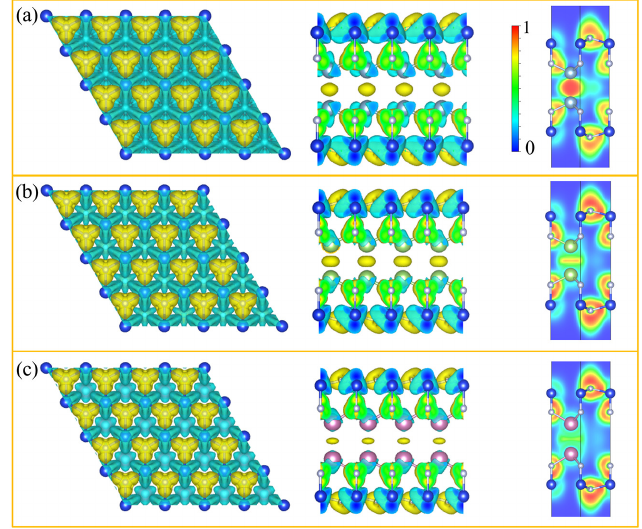
Figure 3. The top and side views of the deformation electron density and electron localization function (ELF) map sliced perpendicularly to (110) direction for ( a ) Al 2 Si 2 N 4 , ( b ) Ga 2 Si 2 N 4 and ( c ) In 2 Si 2 N 4 . The isovalue is set to be 0.01 e/Bohr 3 . The deformation electron density is defined as the M 2 Si 2 N 4 monolayer total charge density, subtracting the sum of isolated atoms. The charge accumulation and depletion regions are shown in yellow and blue,